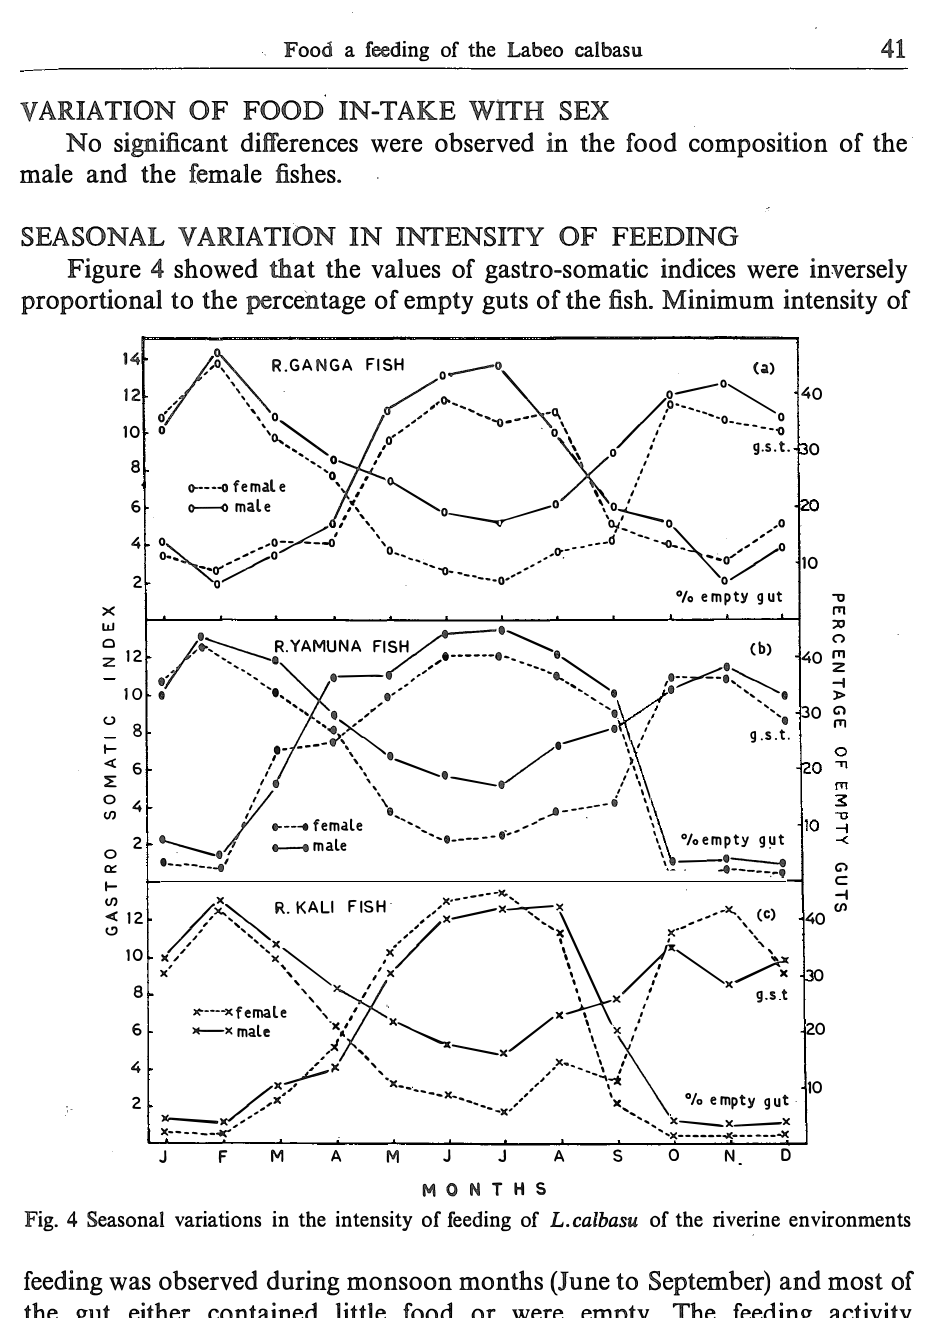
Fig. 4 Seasonal variations in the intensity of feeding of L.calbasu of the riverine environments feeding was observed during monsoon months (June to September) and most of the gut either contained little food or were empty. The feeding activity increased in October and active feeding was recorded up to February . From March onwards the feeding intensity declined and reduced to its lowest level during the monsoon